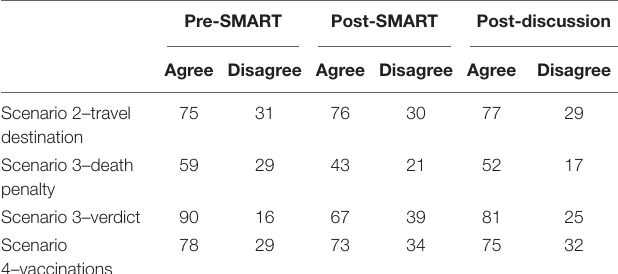
TABLE 1 | Sample sizes of subjects’ stances by scenario at pre-SMART, post-SMART, and post-discussion